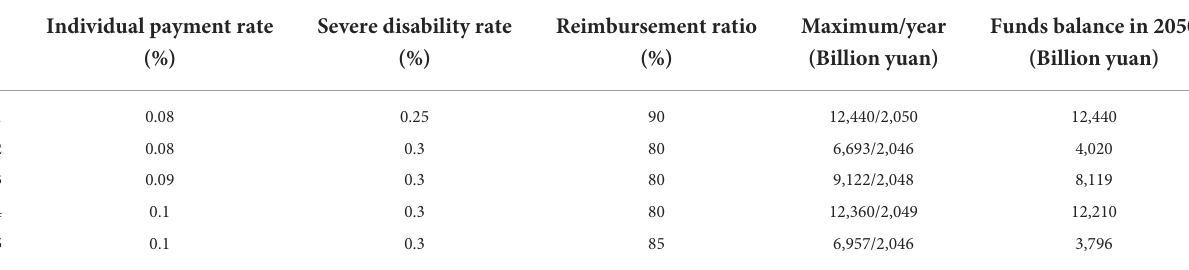
TABLE 1 Assumption of the appropriate